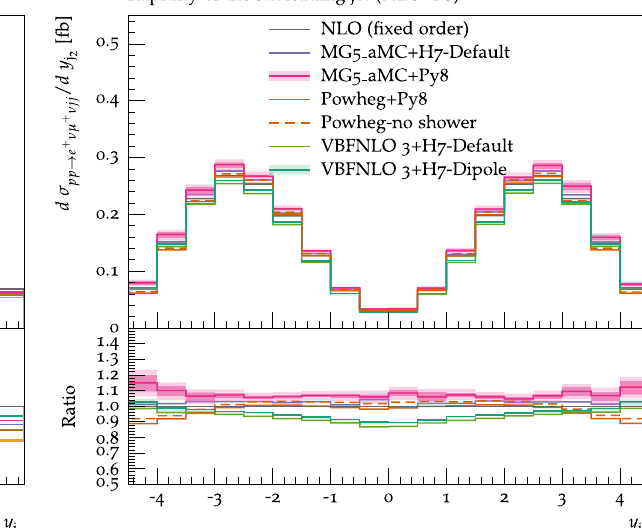
Fig. 17 Differential distribution in the transverse momentum of the second-hardest jet from predictions matched to parton showers, at LO (left) or NLO (right) accuracy (upper plot), compared with the fixed- NLO result computed with VBFNLO (lower plot). At NLO+PS accu- racy, for VBFNLO + Herwig7- Dipole , the three-point scale uncertain-